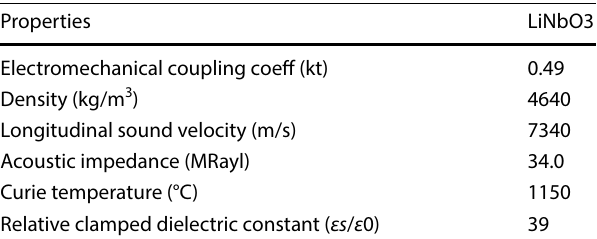
Table 1 LiNbO3 piezoelectric properties (Boston Piezo-optic, Bell- ingham,